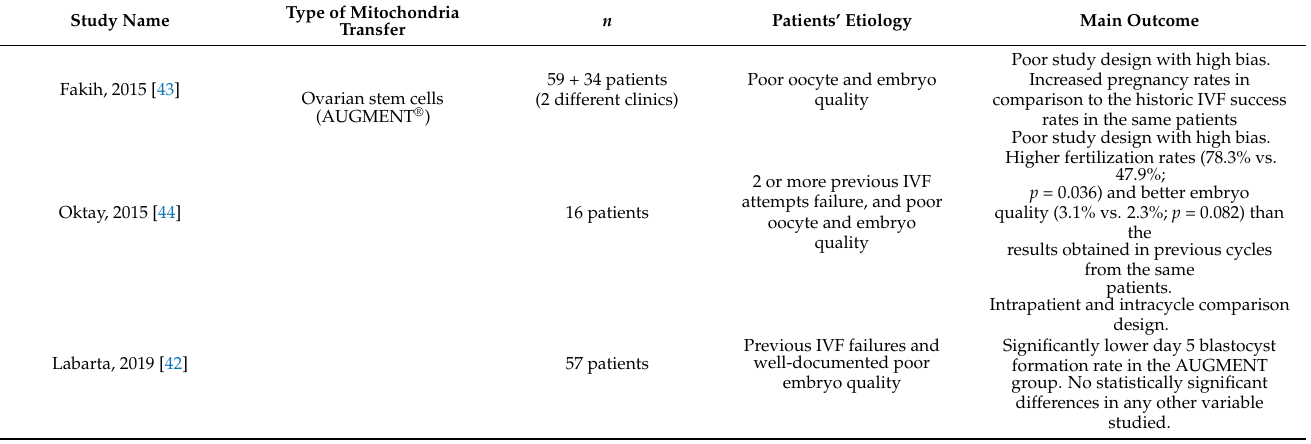
Table 2. Main human clinical studies using autologous mitochondria